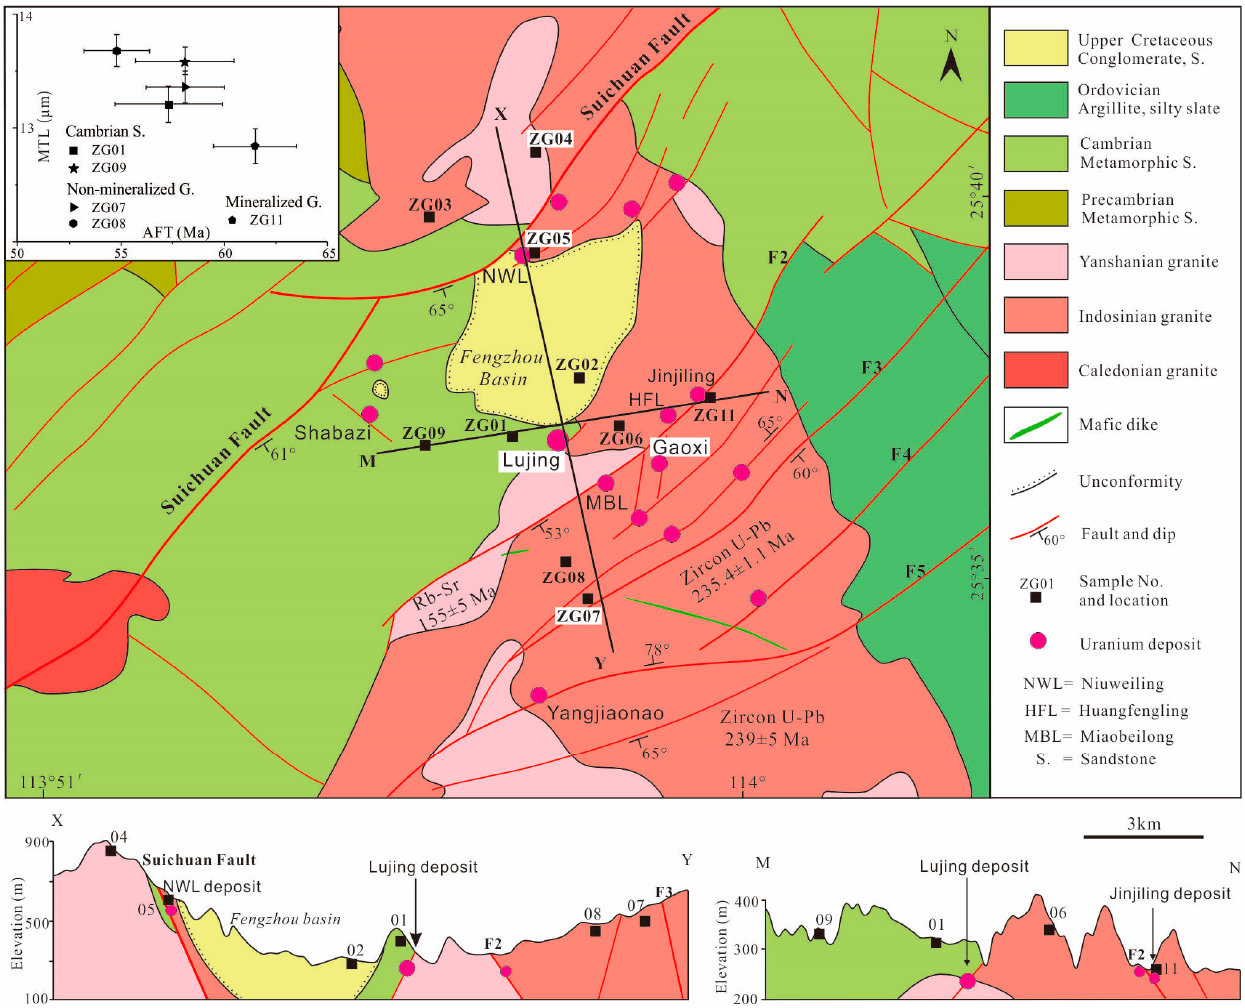
Figure 2. Geological map and cross-sections of the Lujing uranium ore field region showing sample locations, with distribution of uranium deposits and intrusive ages of the Indosinian and Yanshanian granites, for which the references cited do not provide exact sample locations (modified after [6]).